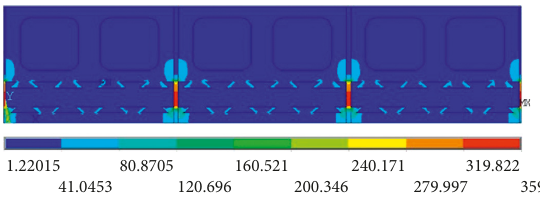
Figure 16: Distribution of heat flux density in the wall. Table 8: Total thermal resistance of the block wall in the experimental test and numerical simulation.